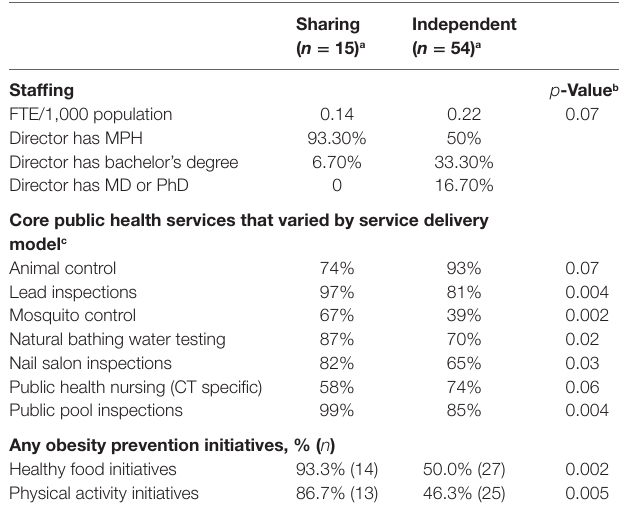
TaBle 6 | Services and staffing of independent and sharing health